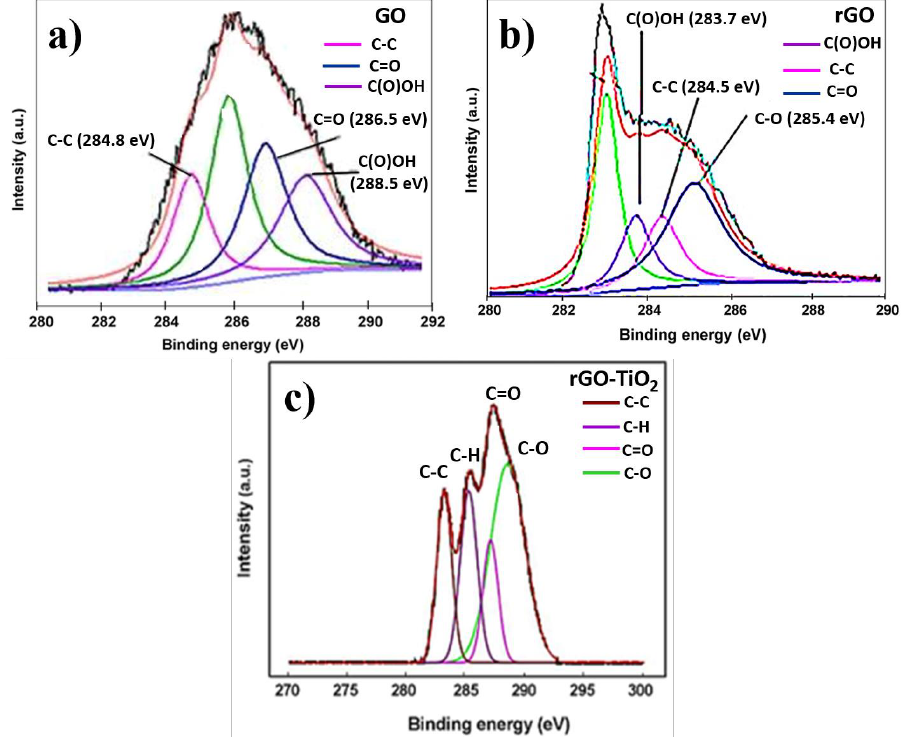
Figure 4. XPS binding energy spectra of C1s spectrum of ( a ) GO, ( b ) rGO, and ( c ) rGO/TiO 2.